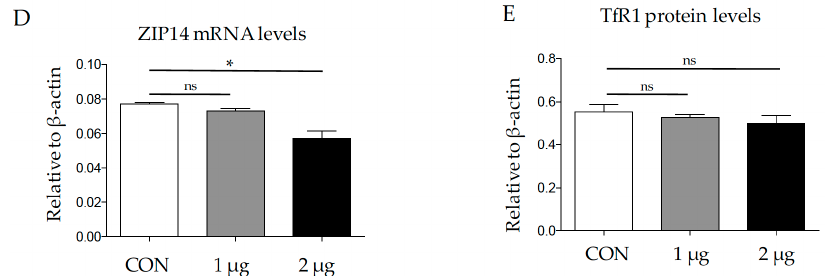
Figure 3. Overexpression of p53 decreases endogenous ZIP14 in HepG2-ZIP14-cells. ( A ) cells were transfected with an empty mammalian expression vector driven by human cytomegalovirus promotor (pCMV) vector (CON) or different amounts of p53- encoding vector for 72 h. Cells lysates were analyzed by immunoblotting for ZIP14, p53, TfR1 and β -actin; ( B – C ) quantification of p53 and ZIP14 protein levels shown in panel A; ( D ) transcript levels of ZIP14 were quantified and normalized to β -actin; ( E ) quantification of TfR1 protein levels shown in panel A. Experiments were repeated at least three times with consistent results. * p < 0.05, ** p < 0.001, *** p < 0.0001, ns: non-significant, compared with control.